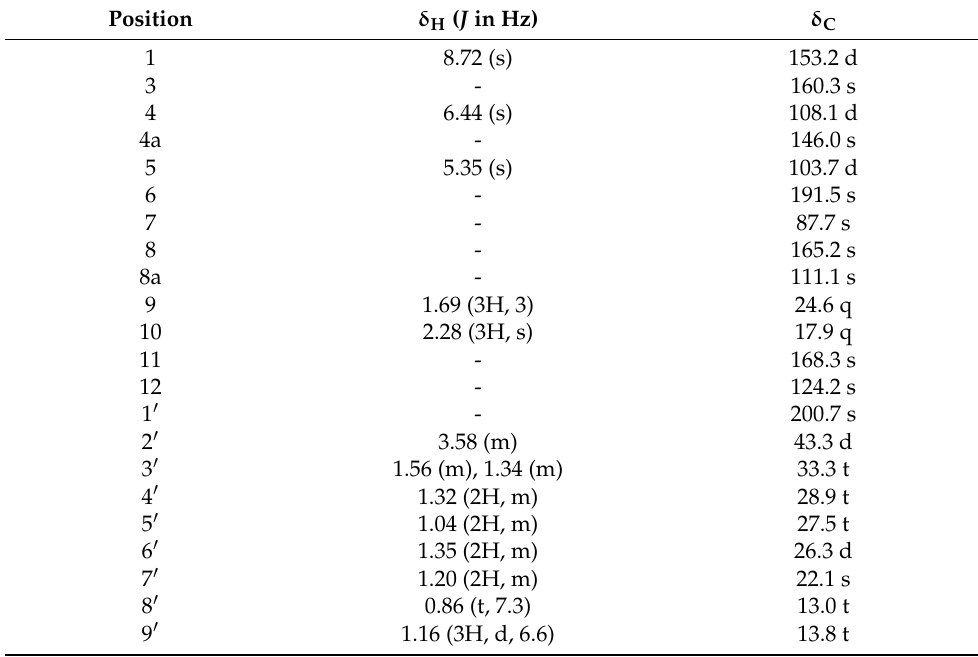
Table 3. 1 H (500 MHz) and 13 C-NMR (125 MHz) data for compounds 5 (CD 3 OD).